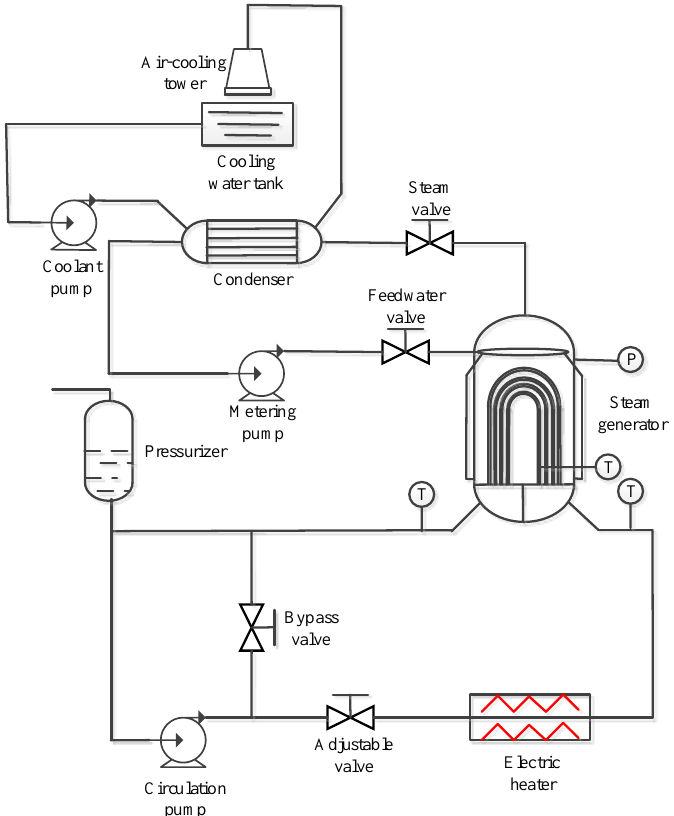
Figure 3. Experiment loops.